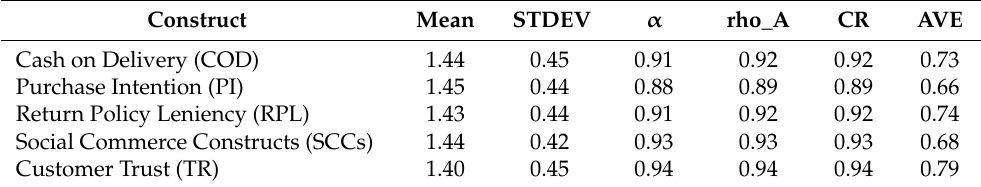
Table 2. Convergent validity.